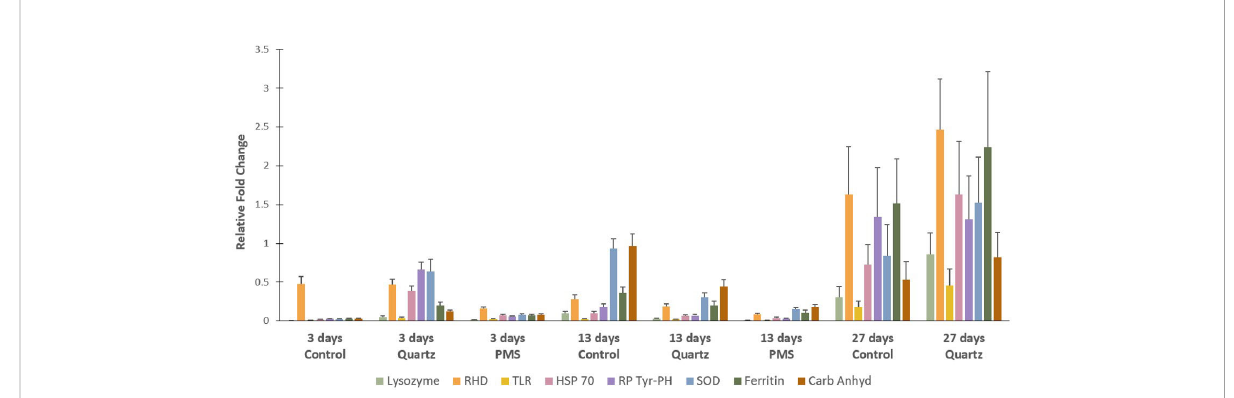
FIGURE 9 Relative gene expression of selected genes for the Dentomuricea aff. meteor during the experiment (times 3, 13, 27) in treatments with polymetallic particles (PMS), with quartz particles (Quartz) and in the control treatments with no sediment addition. Values are means of the relative gene expression normalized with the expression of two reference genes - 18S and b -actin - and relative to expression levels in T0, just prior to the start of the experiment. Expression levels (fold change) for the different target genes, Lysozyme, RHD (Rel Homology Domain), TLR (Toll-like receptor), HSP70 (heat shock protein 70), RP Tyr-PH (receptor-type protein tyrosine phosphatase), SOD (Superoxide Dismutase), Ferritin and Carb Anhy (alpha-carbonic anhydrase) are represented in different colour bars. Data expressed as mean ± standard error. Three technical replicates and n=6 for all treatments at times T3 and T13 days, n=2 for control treatment at T27, no fragments in the PMS treatment at T27.